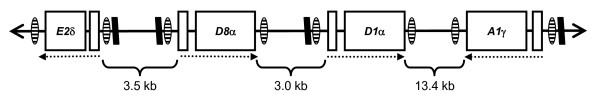
Structure of part of the 185/333 locus. Scaffold_v2_79421 from the S. purpuratus genome assembly (Version 2, June 15, 2006) contains four linked 185/333 genes (diagram not to scale). Each of the genes includes a single intron in the predicted location. The element patterns of the genes are based on the cDNA-based alignment are indicated. Pattern D8 was not isolated from the cloned genes; however, it is similar to pattern D1, but contains Ex12 rather than Ex10. The orientations of the genes are indicated by the arrows. Dinucleotide (GA; striped ovals) flank the genes and trinucleotide repeats (GAT; solid parallelograms) are present on the 5' side of the genes.